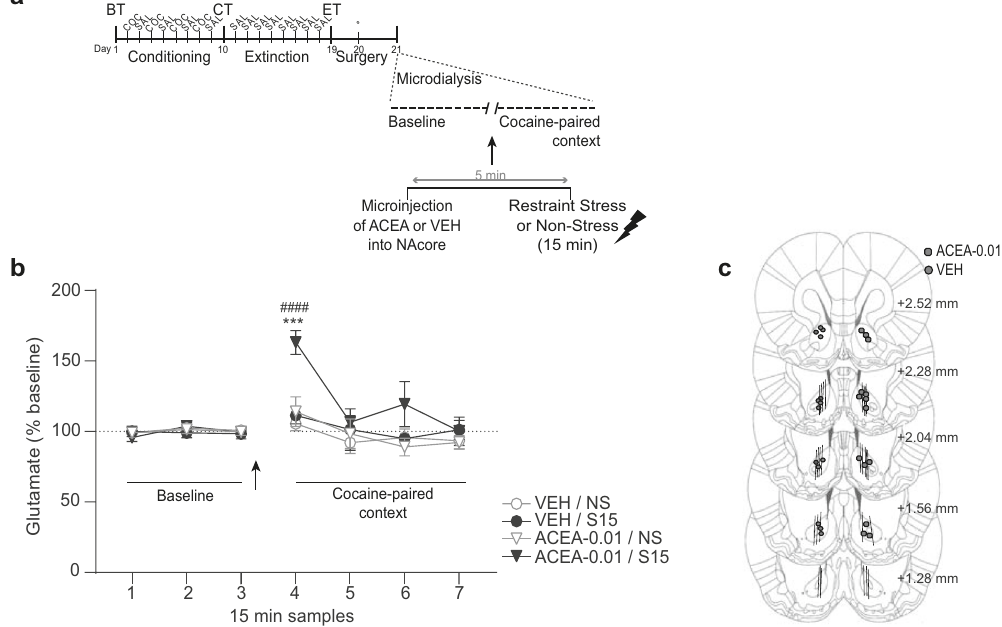
Figure 4. CB1R agonism within NAcore, in combination with subthreshold restraint stress, induced an increase in extracellular glutamate in NAcore. ( a ) Timeline of CPP procedure. Stereotaxic surgery for microdialysis probe implantation was performed once animals reached extinction criteria. The day after surgery, in vivo microdialysis was used to sample (every 15 min) extracellular glutamate in NAcore both before (baseline determination, in home cage) and after ACEA (or VEH) intra-NAcore administration and 15 min of restraint stress (or non-stress). Following treatments, samples were collected inside the cocaine-paired compartment of the CPP apparatus. Glutamate was quantified using EZChrom Elite software, version 4.0 (http:// www. agile nt. com). ( b ) ACEA local pretreatment potentiated the increase in glutamate of NAcore measured in the cocaine-paired context immediately after a subthreshold session of restraint stress (***p < 0.001 compared with other groups at the same time point; #### p < 0.0001 compared with the last baseline sample, Bonferroni’s multiple comparisons post-hoc test). Values represent percentage of increase in glutamate release from baseline (mean ± s.e.m.) for each 15 min sample, n = 6–7 for each group. Arrow indicates the microinjection and restraint stress treatment. ( c ) Approximate unilateral locations of microinfusions of ACEA performed into NAcore together with the dialysis membranes placements (solid lines) of rats implanted with the dual microinjection- microdialysis probes. Numbers to the right indicate millimeters from the Bregma. Symbols represent the different microinjections